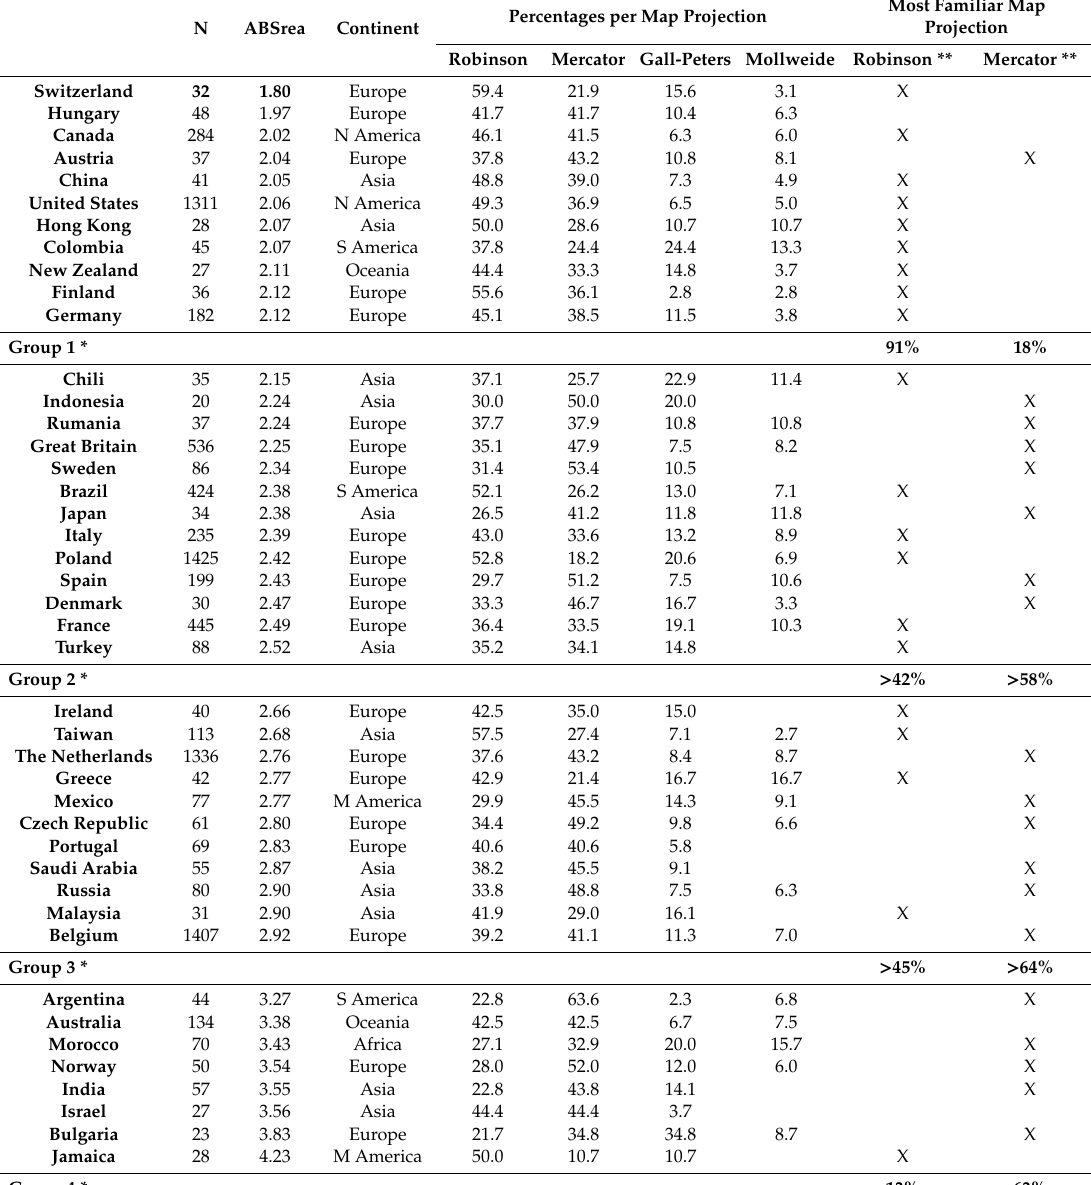
Table 11. Number of participants (N), the average absolute values of the relative estimated accuracy (ABSrea), and the most familiar map projection per country / region. The data are ranked by ABSrea. Most Familiar Map Percentages per Map Projection Projection N ABSrea Continent Robinson Mercator Gall-Peters Mollweide Robinson